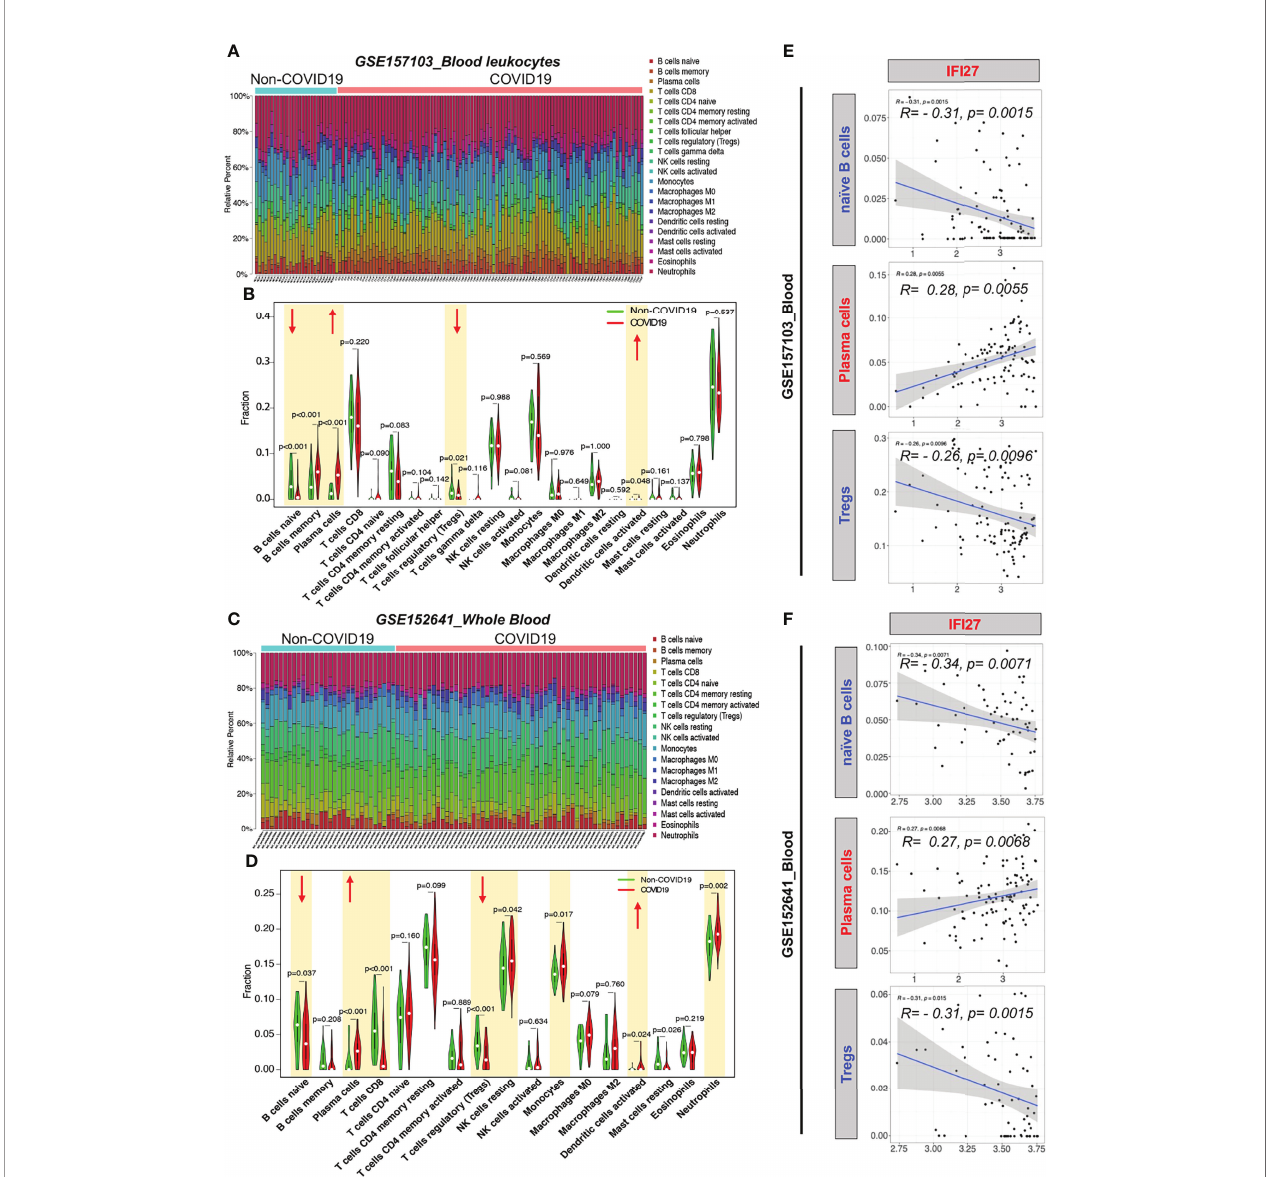
FIGURE 6 | CIBERSORT analysis of immune cell count in the blood of patients with COVID-19. (A) Distribution proportion of immune cells in each sample from GSE157103. (B) Statistical analysis of various immune cell types in blood leukocytes from patients with COVID-19 and non-COVID-19 patients in GSE157103. (C) Distribution proportion of immune cells in each sample from GSE152641. (D) Statistical analysis of various immune cell types in whole blood from patients with COVID-19 and non-COVID-19 patients in GSE152641. (E) Correlation analysis between IFI expression and immune cell content in GSE157103. (F) Correlation analysis between IFI expression and immune cell content in